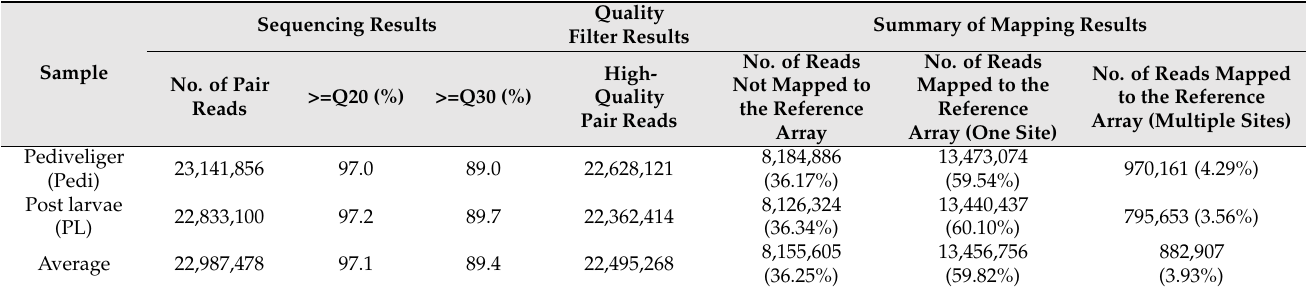
Table 2. Statistics summary of the Pacific oyster, Crassostrea gigas ,